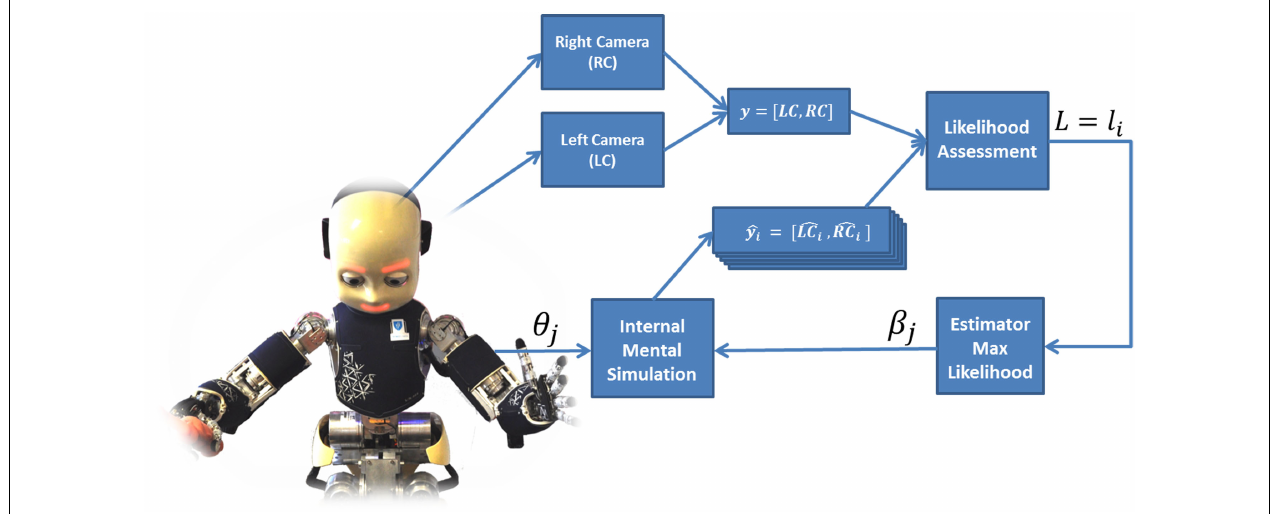
FIGURE 1 | The iCub humanoid robot uses its internal mental simulation to imagine (generate synthetic images of) the hand pose in real time . By comparing the generated images ( ^ y i ) to the ones obtained through stereo vision (y), it simultaneously achieves better hand pose estimation and automatic calibration of the internal